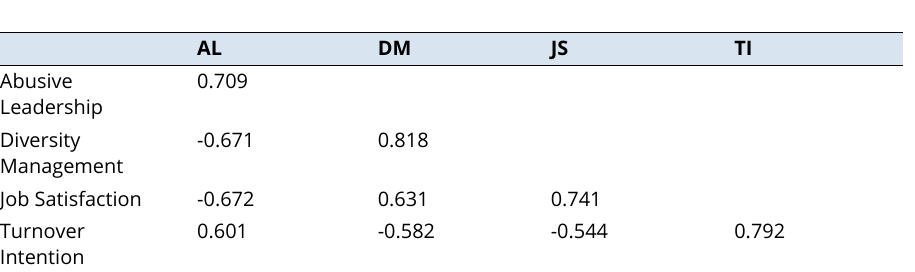
Fornell-Larcker